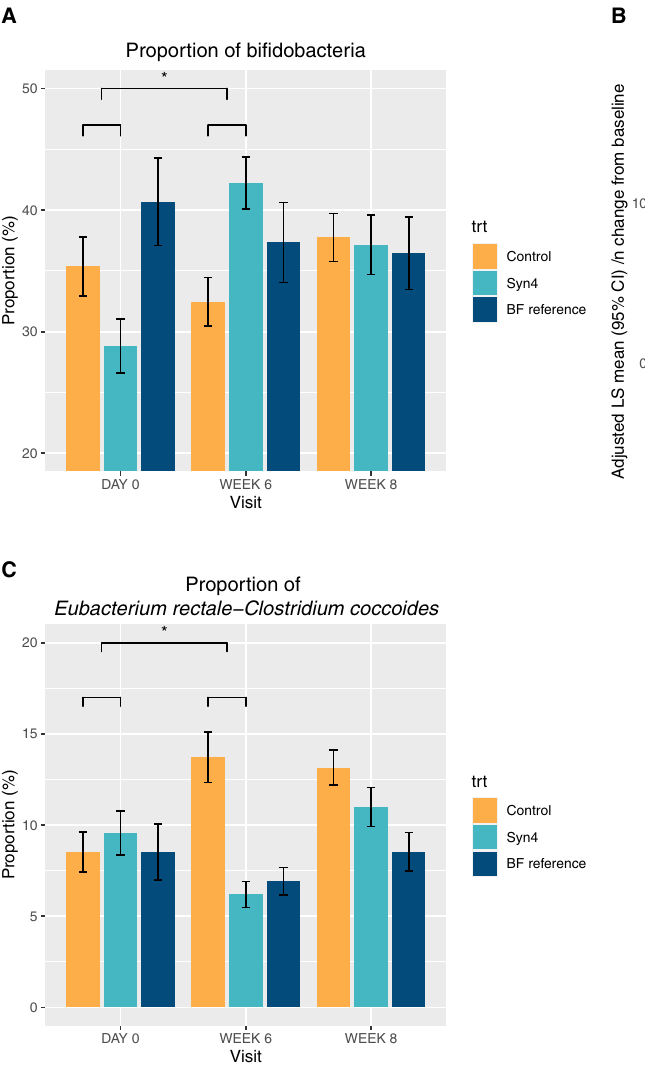
Figure 3. FISH analyses of fecal samples from the control treatment, Syn4 dose treatment and breastfed (BF) reference group. After 6 weeks the Syn4 dose treatment (trt) resulted in a significantly larger increase in the relative abundance (proportion) of bifidobacterial from baseline compared to control ( A ). ( B ) Shows adjusted LS mean (95% CL)/n change from baseline in relative abundance of bifidobacterial for the control and the Syn4 groups. Syn4 treatment lead to a significantly larger decrease in the relative abundance of Eubacterium rectale– Clostridium coccoides from baseline compared to control ( C ). A longitudinal linear mixed model was used with intervention, time, study site as fixed factors, intervention by time as interaction term and subject as a random effect. Data are expressed as mean ± SE. *Statistically significant difference in change from baseline between treatment groups (p-value < 0.05) as assessed by the linear mixed-effect